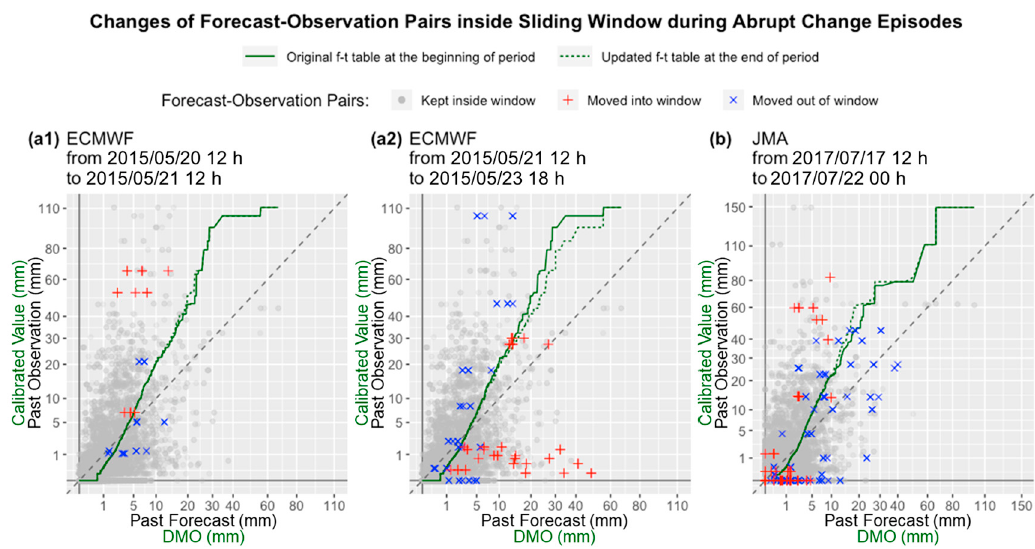
Figure 6. Changes of the forecast–observation pairs inside the sliding window when its head slides through time during the episodes of abrupt changes in calibrated values: ( a ) the ECMWF episode from 20 May 2015 12 h to 23 May 2015 18 h, subdivided into ( a1 ) from 20 May 2015 12 h and ( a2 ) from 21 May 2015 12 h to 23 May 2015 18 h, and ( b ) the JMA episode from 17 July 2017 12 h to 22 July 2017 00 h. The green lines connect f-t pairs ( solid ) at the beginning and ( dotted ) at the end of the period concerned respectively, so the y -coordinates would approximately be the calibrated forecast for the x -coordinates using the f-t conversion table at that time. Both axes are in square root scale.